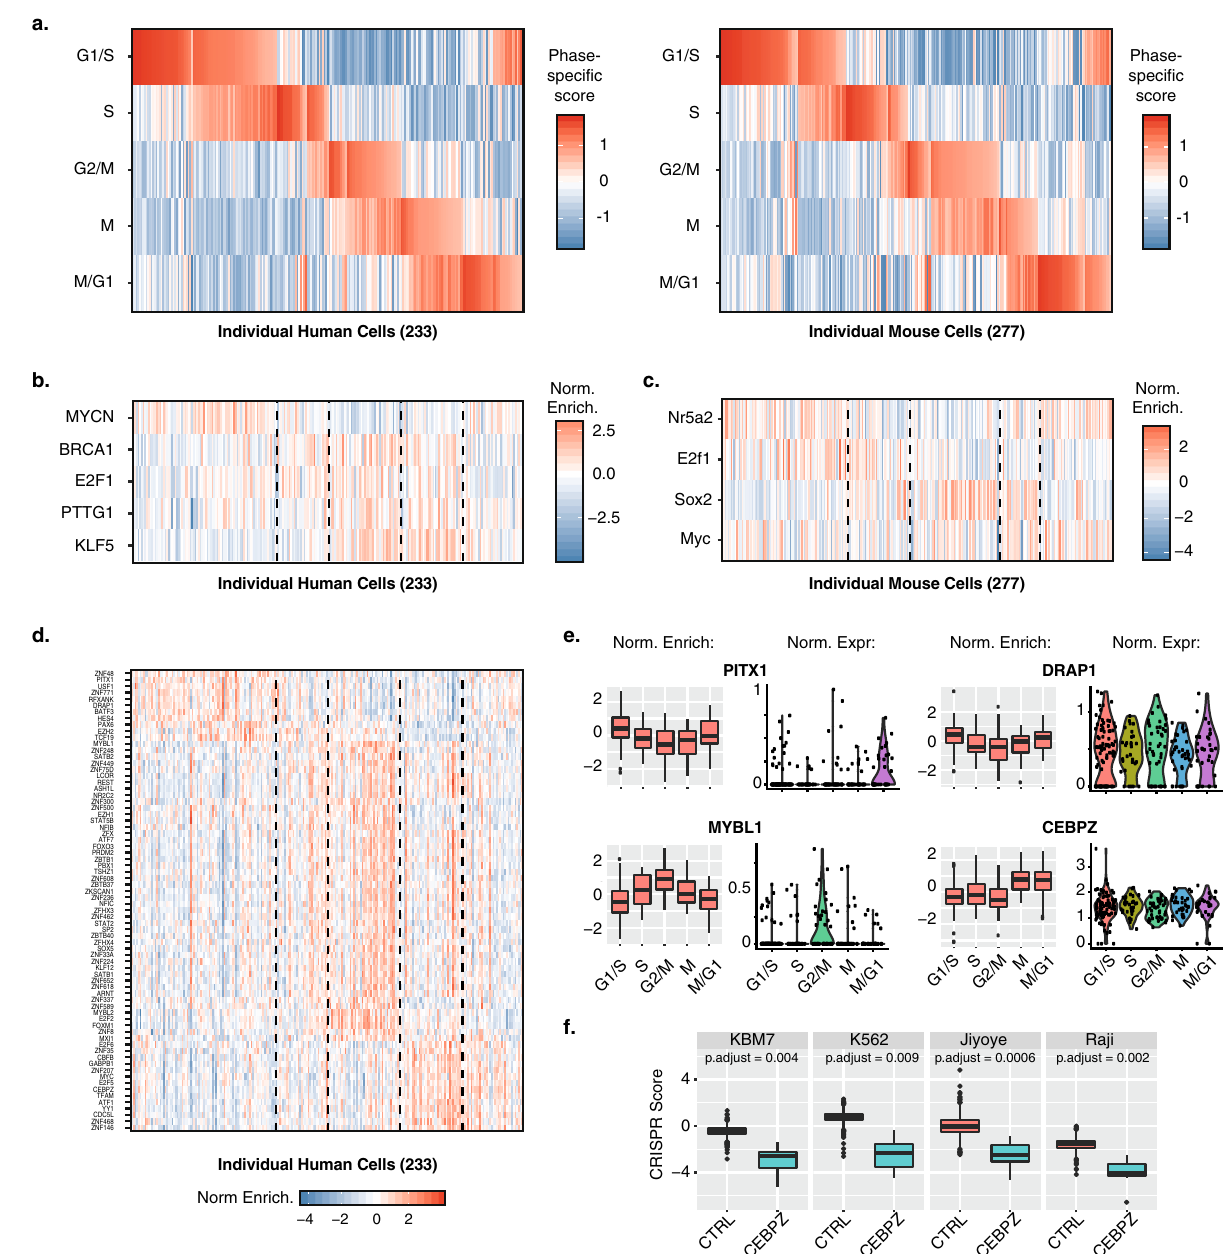
Figure 3. Elucidating transcriptional regulatory networks of the cell cycle. ( a ) Inferred cell cycle states of 233 human HEK293 cells (left panel) and 277 mouse 3T3 cells (right panel) based on the gene expression profiles of individual cells relative to stage-specific gene sets (see “Methods” section). Cells are ordered by the combination of phases switched on in each individual cell. ( b ) Inferred activity of indicated transcription factors based on TRRUST defined regulon expression in individual human HEK293 cells. Dashed lines highlight cell cycle phase assignments used to determine correlation to transcription factor activity. Normalised scores for each transcription factor have been mean centred across all cells. ( c ) Same as ( b ) but for mouse transcription factors and individual mouse 3T3 cells. ( d ) Inferred activity of indicated transcription factors in individual human HEK293 cells based on the summarised expression of regulons that had been inferred from 24 TCGA human cancer tissue sets. Dashed lines highlight cell cycle phase assignments used to determine correlation to transcription factor activity. Normalised scores for each transcription factor have been mean centred across all cells. ( e ) Boxplots showing normalised inferred activity and normalised gene expression across different phases for selective transcription factors shown in ( d ). Normalised activity and expression scores for each transcription factor were mean centred across all cells before being summarised by assigned cell cycle phase. ( f ) Boxplots showing CRISPR scores in four independent cell lines when using control sgRNA (n = 953) or sgRNA targeting CEBPZ (n = 7). CRISPR scores reflect the log2 fold change of each sgRNA detected in the cell lines between the start and end (~ 14 population doublings) of pooled CRISPR depletion